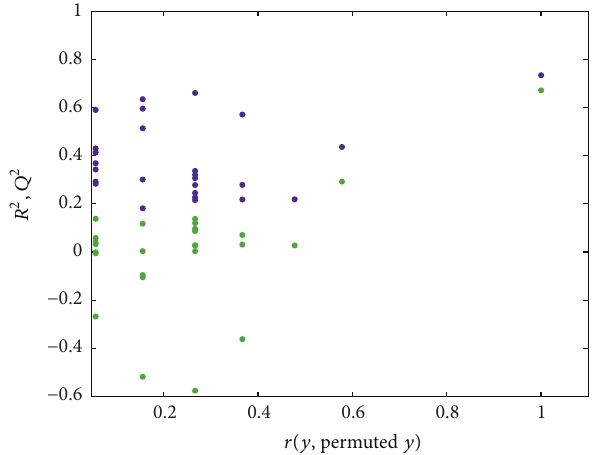
Figure 5: Permutation test of PLS model based on NMR data of first two stages.